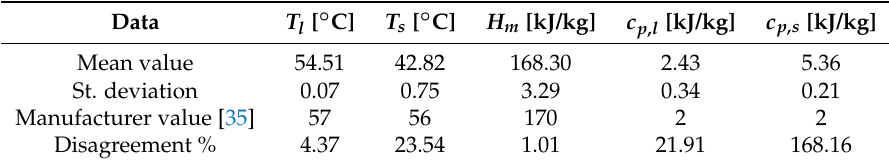
Table 3. Determination of thermal properties with T-history to RT55 paraffin.